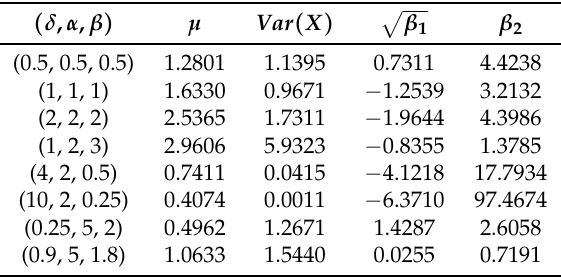
Table 1. Mean, variance, coefficients of skewness and kurtosis for different values of parameters. ( δ , α , β ) µ Var ( X ) (cid:112) β